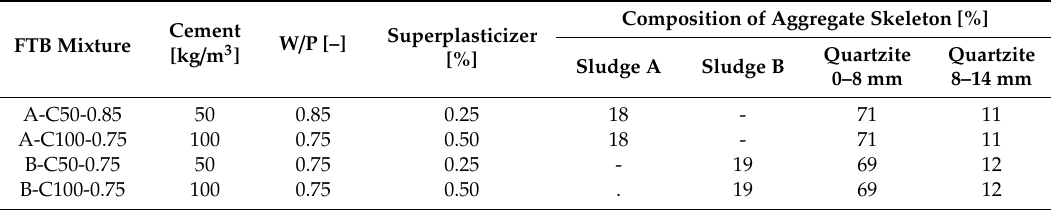
Table 7. Composition of investigated Fluidized Thermal Backfills (FTB)